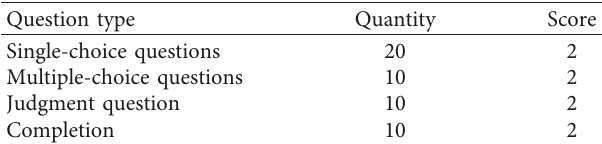
Table 1: Question-type setting.